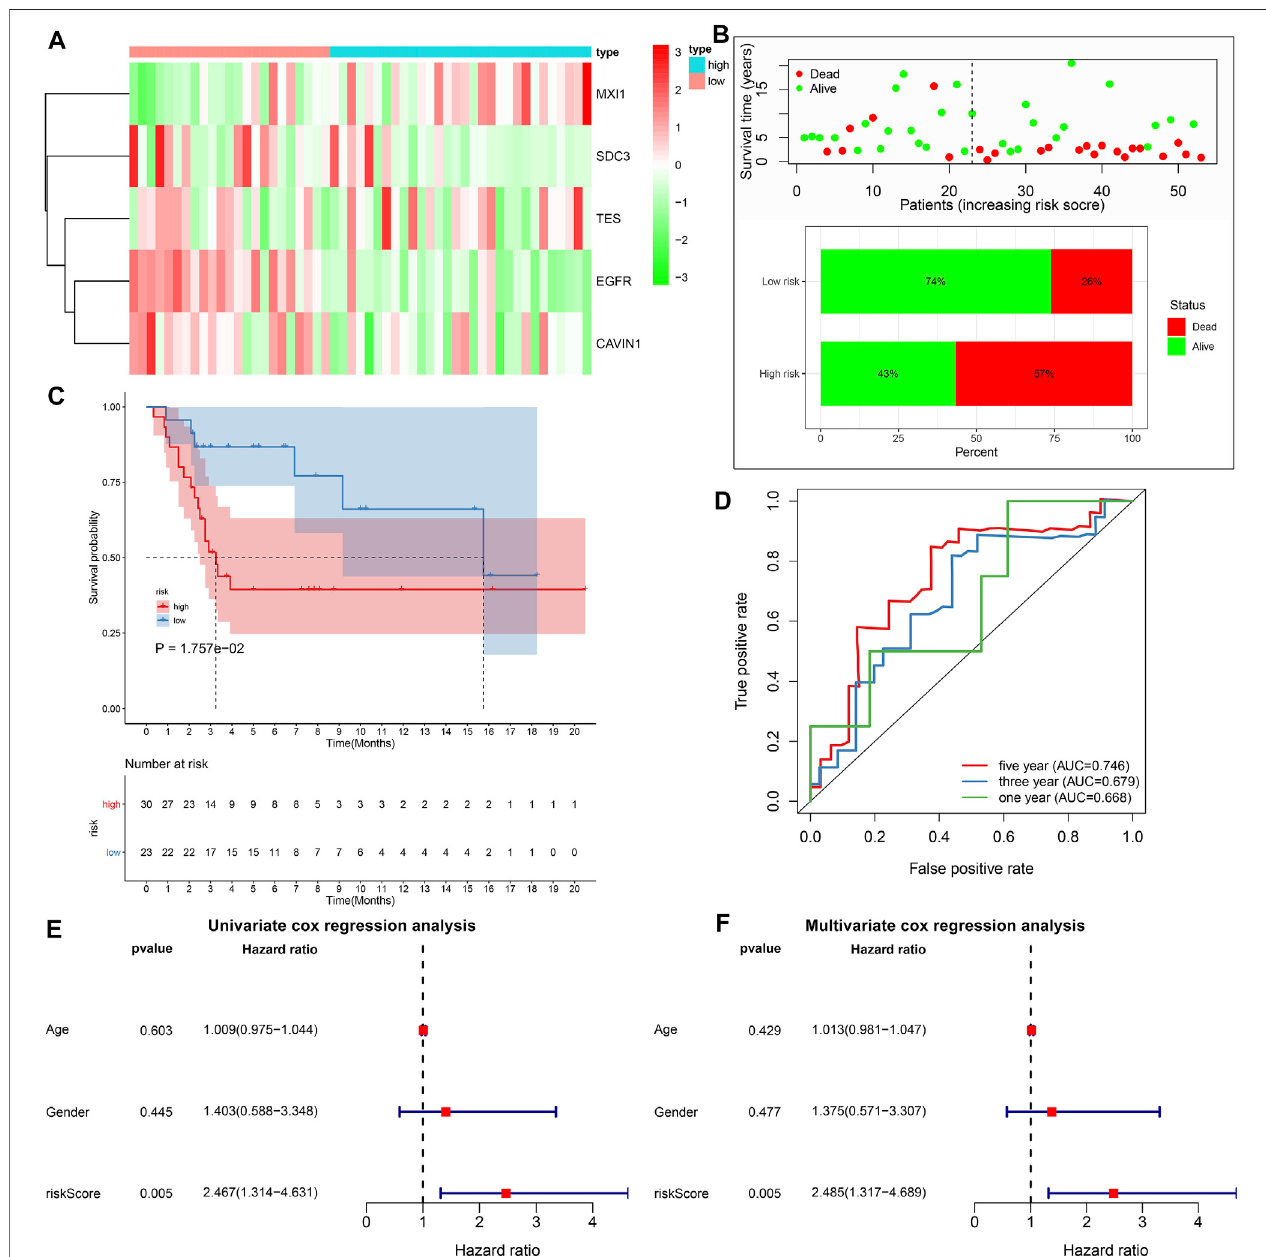
FIGURE 4 | External validation of the predictive performance of hypoxic gene signature on osteosarcoma prognosis in the GSE21257 cohort. (A) Heat map visualizing the up- (red) and down-regulated (green) genes in high- and low-risk groups. (B) The distributions and proportions of survival status (alive: green; dead: red). (C) Kaplan-MeiercurvesofOSbetweenhigh-andlow-risksubjects.Thedifferenceswerecomparedbylog-ranktests. (D) Time-independentROCcurvesof1-,3-,and 5-years survival based on risk score. (E, F) Univariate and multivariate cox regression analyses for the associations between prognosis and age, gender, and risk